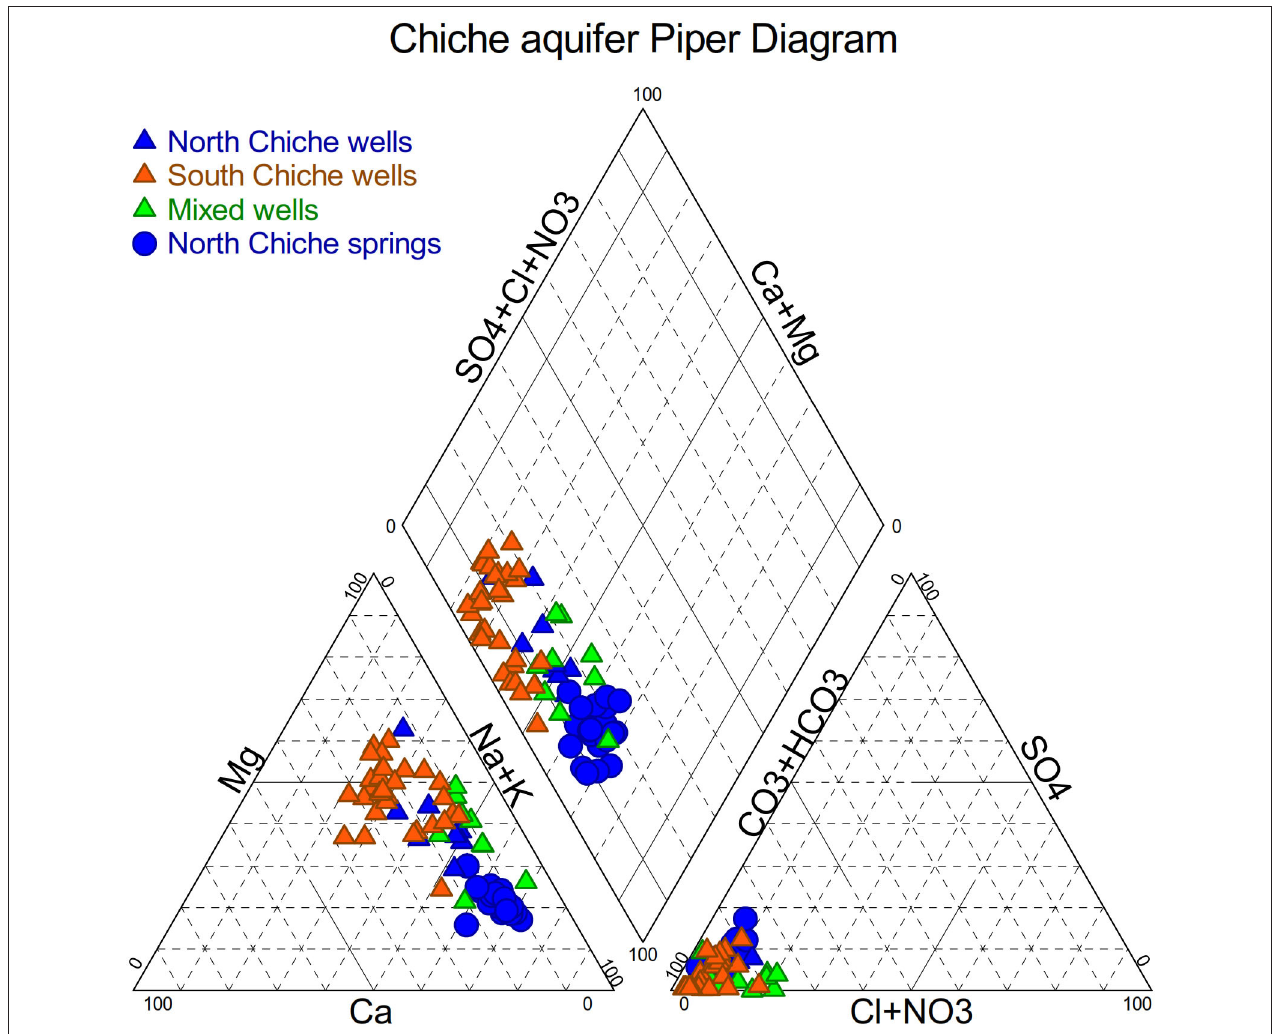
FIGURE 5 | Chiche aquifer Piper